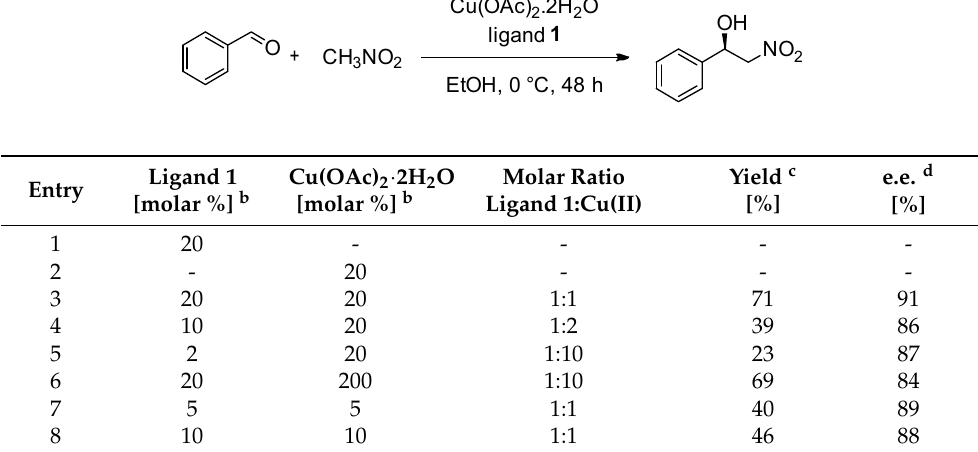
Table 1. Effect of molar ratios ligand 1 : copper(II) acetate: benzaldehyde on the reaction of benzaldehyde with nitromethane a . O CH 3 NO 2